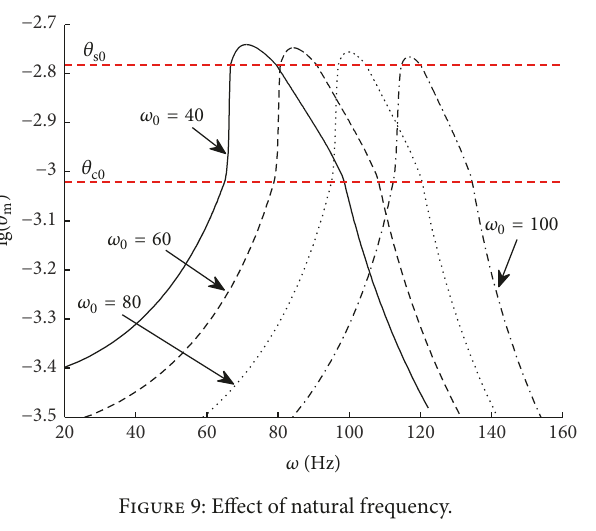
Figure 11: Effect of excitation amplitude. Figure 12: Effect of excitation